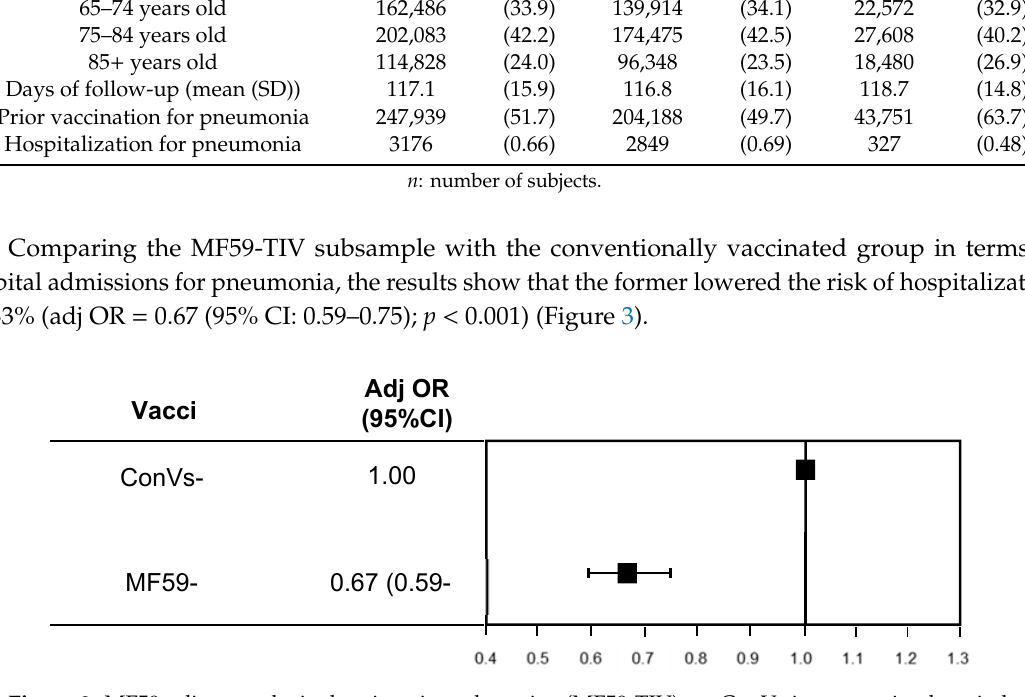
Figure 3. MF59-adjuvanted trivalent inactivated vaccine (MF59-TIV) vs. ConVs in preventing hospital Figure 3. MF59 ‐ adjuvanted trivalent inactivated vaccine (MF59 ‐ TIV) vs. ConVs in preventing hospital admissions for admissions for pneumonia.